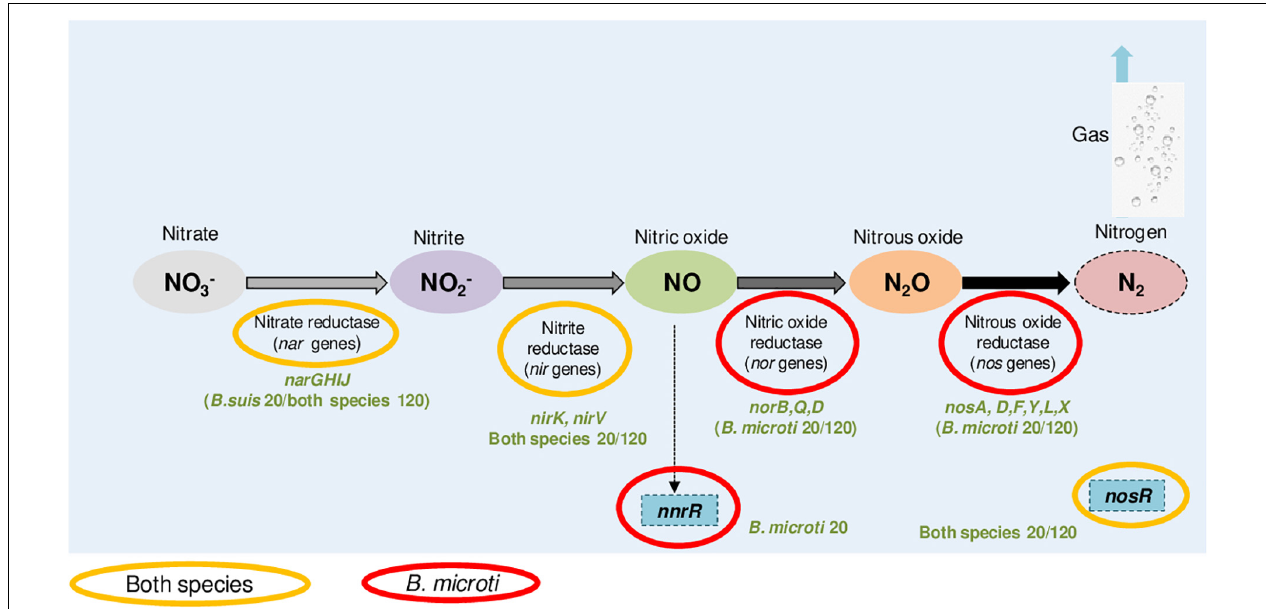
FIGURE 5 | B. microti and B. suis genes of the denitrification pathway with increased expression at pH 4.5. Color codes indicate the species and the experimental time points (20 or 120 min) for each of the genes identified as being more expressed at pH 4.5 than at pH